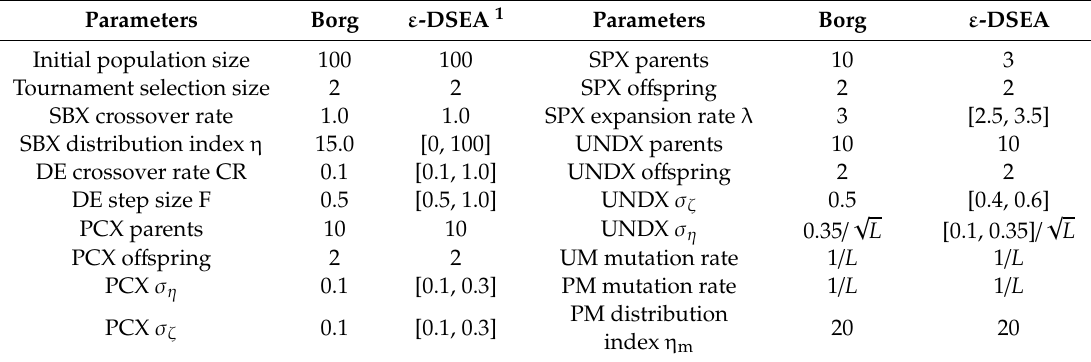
Table 4. Parameter values used in the optimization